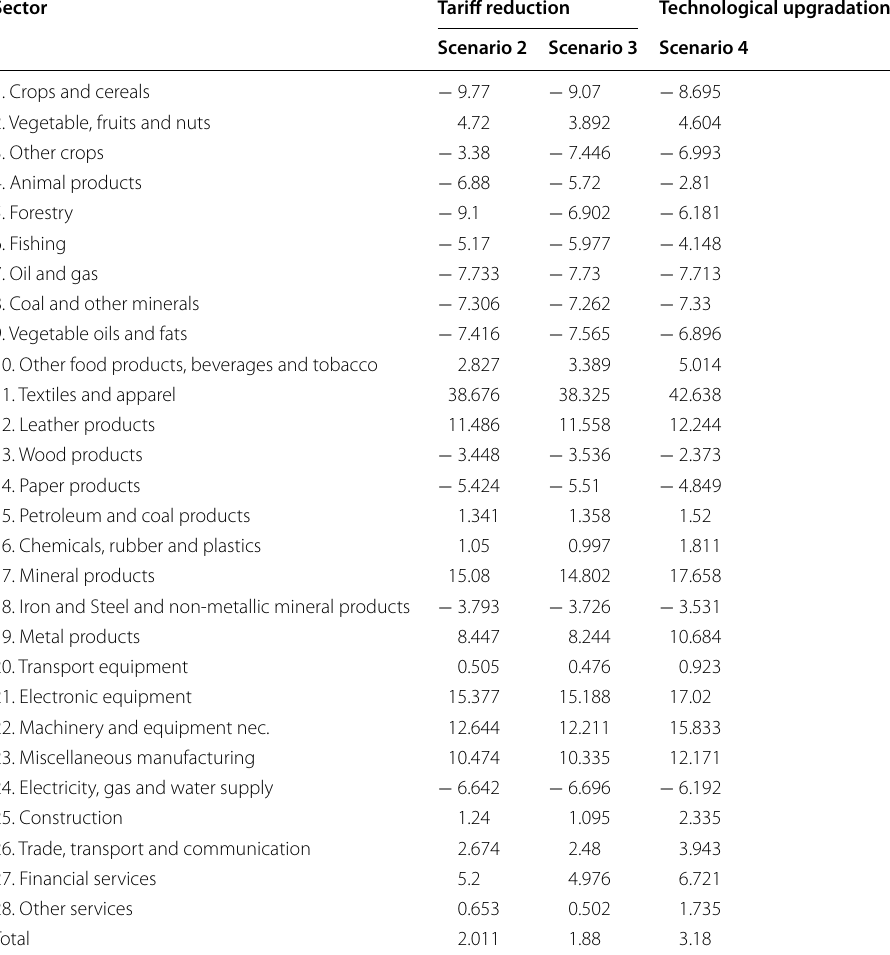
Table 6 Sectoral import growth due to tariff simulation and technological upgradation at 2030 compared to BAU 2030 (USA as TPP